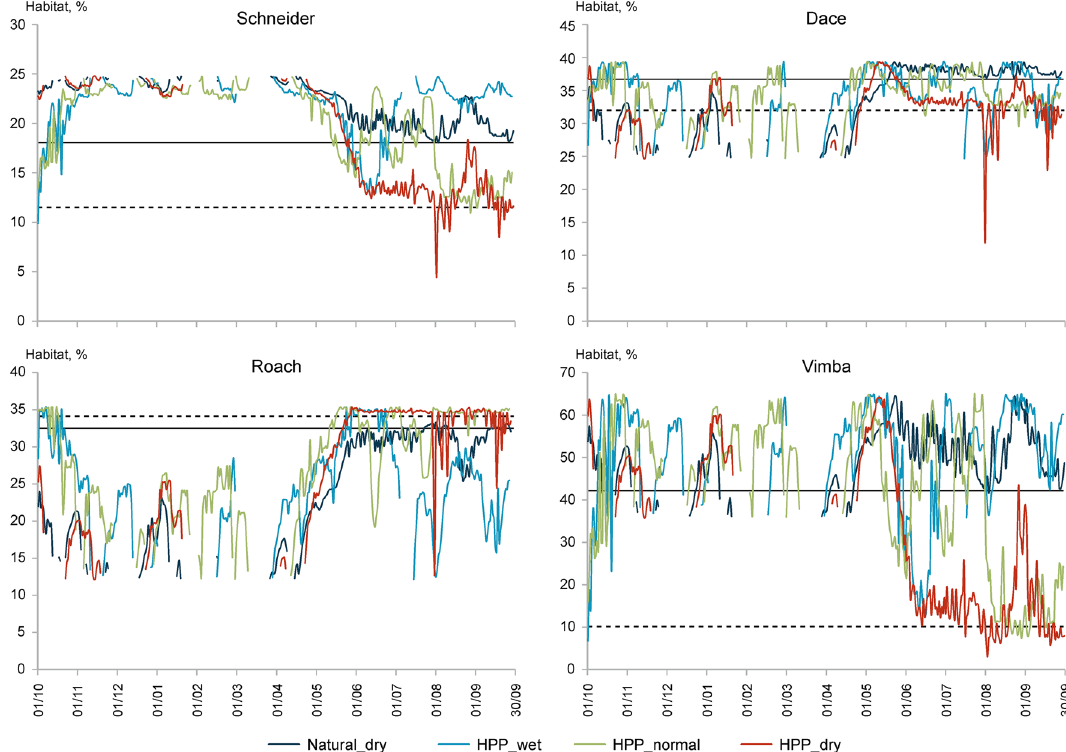
Figure 6. Time series of the suitable habitat area for the different fish species in the Venta River below Kuodžiai HPP for 12 months at natural conditions in a dry year and when HPP operates in a wet, normal, and dry year. The vertical axis represents habitat area (% of channel). The horizontal solid line indicates the habitat area at a Q 97 discharge at natural conditions in a dry year, and the dashed line indicates the average area of the available habitat in July–August, when HPP operates in a dry year.